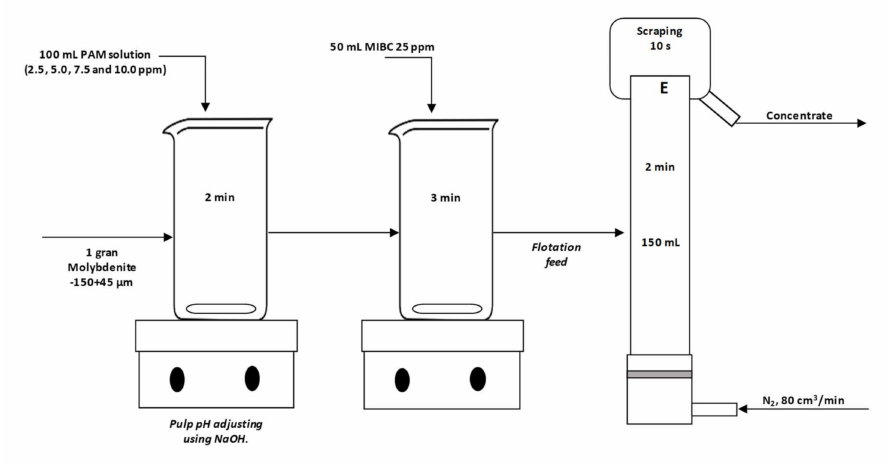
Figure 2. Schematic of the microflotation